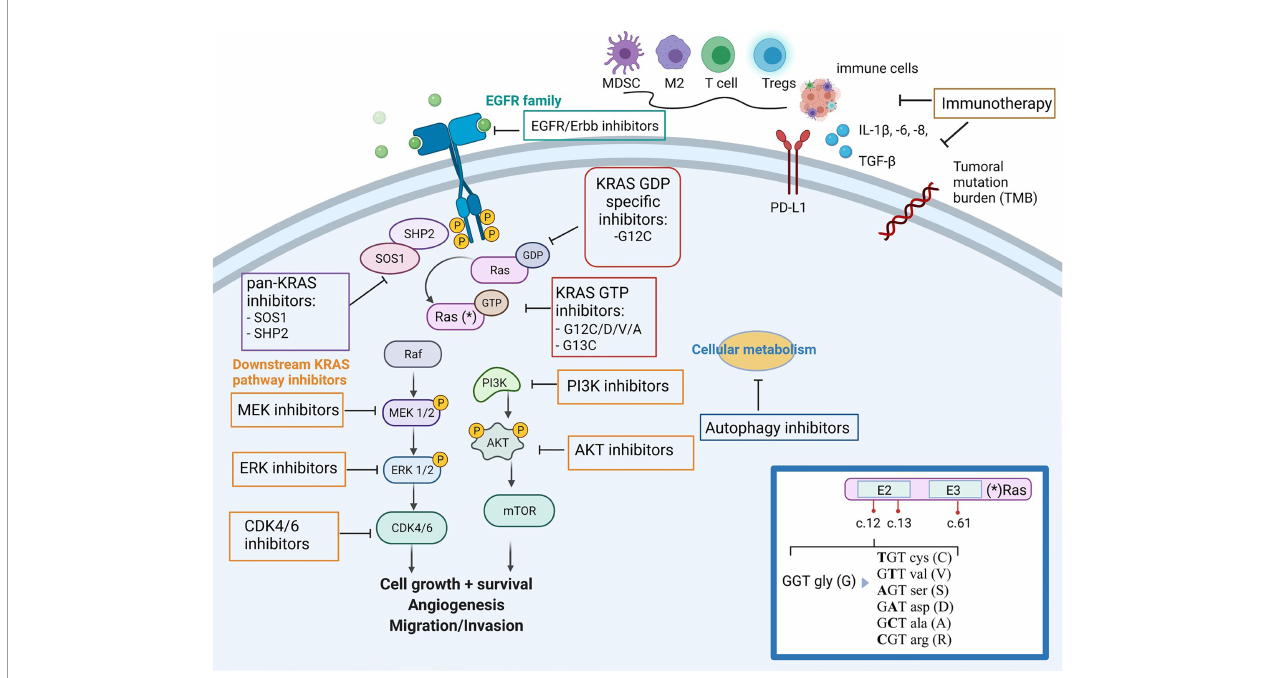
FIGURE 1 | Simpli fi ed overview of KRAS mutant tumor, downstream/upstream KRAS pathways, its impact on the immune-microenvironment and family of drugs targeting KRAS mutant tumors. (*) In the inset box, the oncogenic mutations in codon 12 of KRAS and aminonacid changes. Figure has been created with BioRender.com